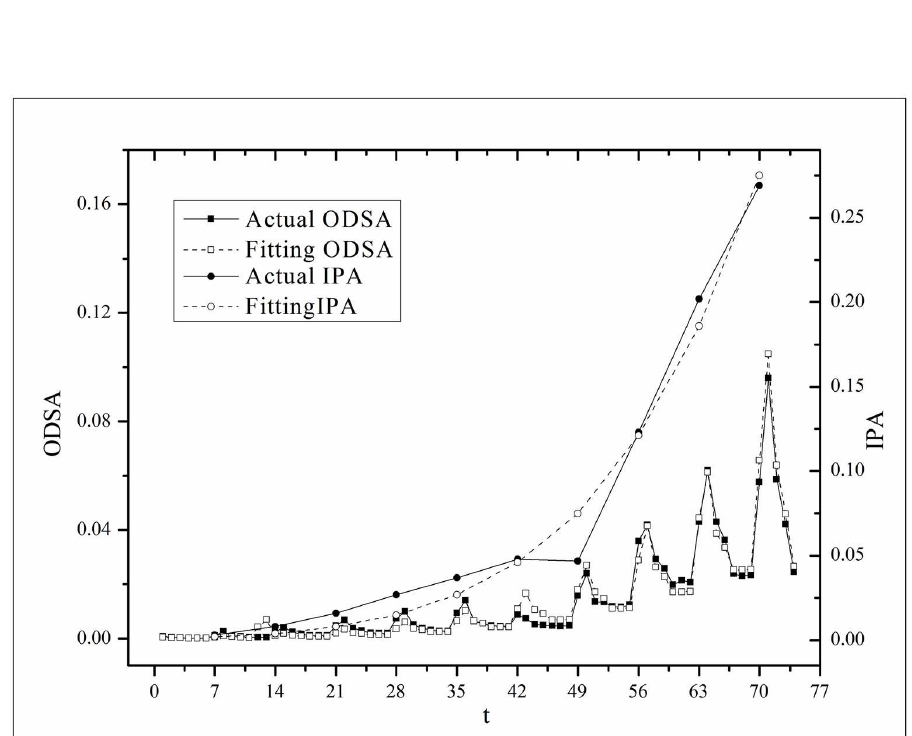
Fig 5. Two-step fitting results for the Love